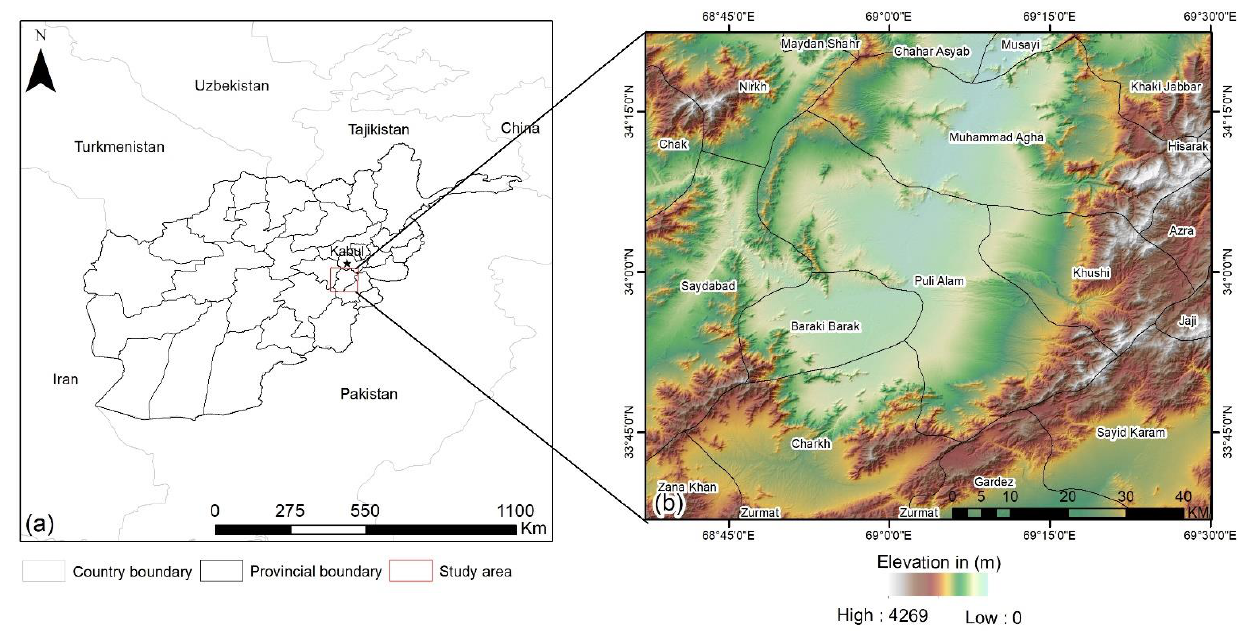
Figure 1. The geographical location of Logar Ophiolite Complex; ( a ) the overall location of Logar Ophiolite Complex in Afghanistan, ( b ) hillshade-based relief of study area derived from DEM-SRTM 1Arc-Second downloaded from Earth Explorer of the NASA.